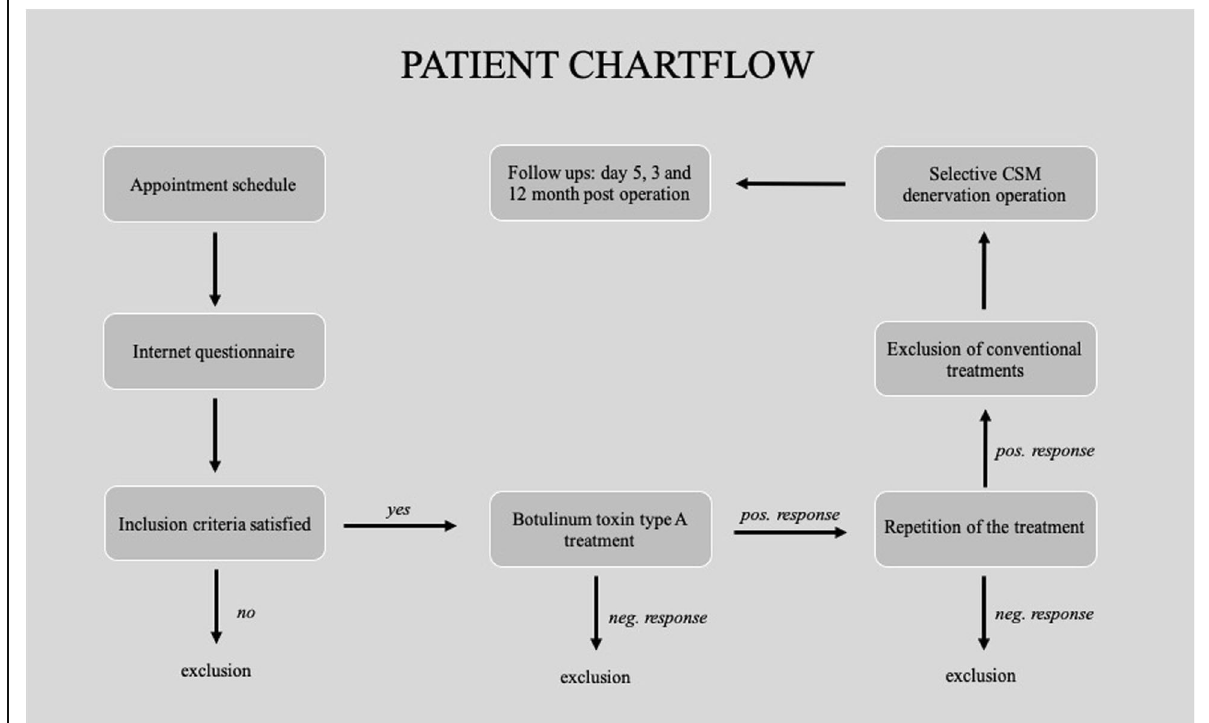
Fig. 2 Patient flowchart. After failing to respond to conventional migraine treatments, patients were selected based on a positive (close to 100%) response to BTA injections. BTA injection were repeated 3 times in these patients and consistently achieved near to 100% remission